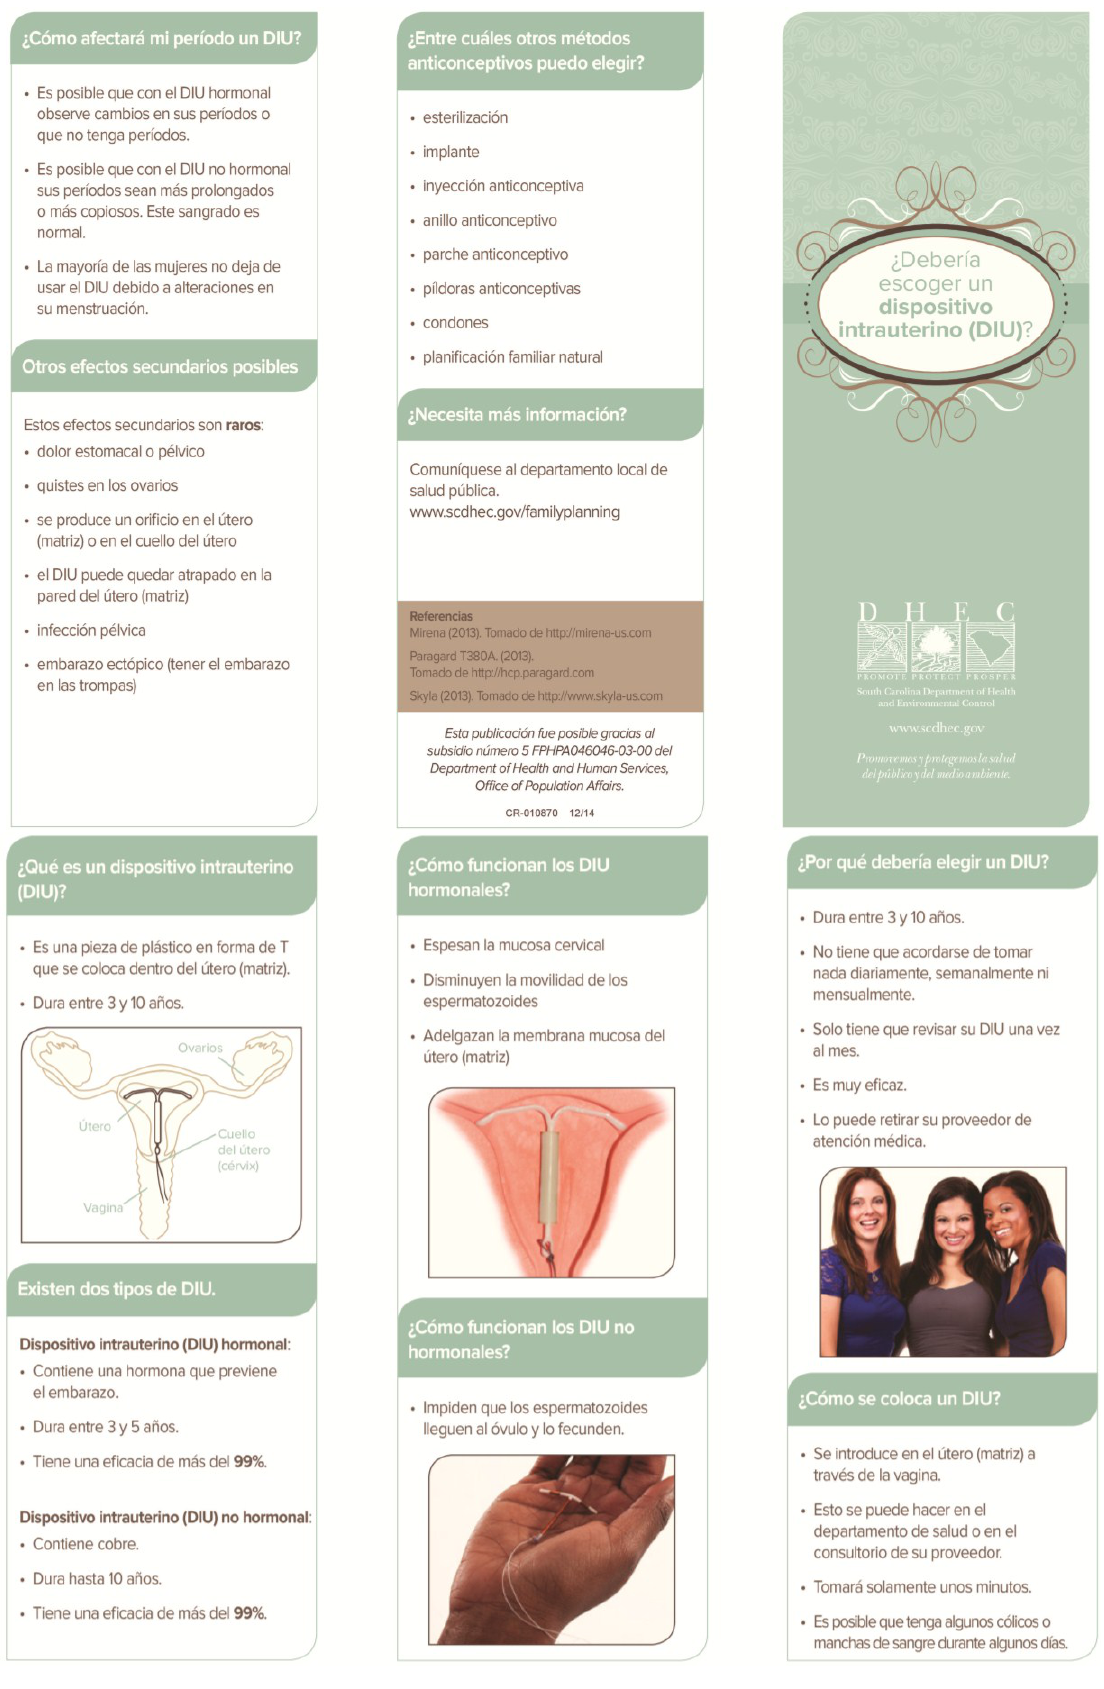
Figure 4. Shared Decision Aid, Spanish Language: “¿Debería escoger un dispositivo intrauterino(DIU)?”